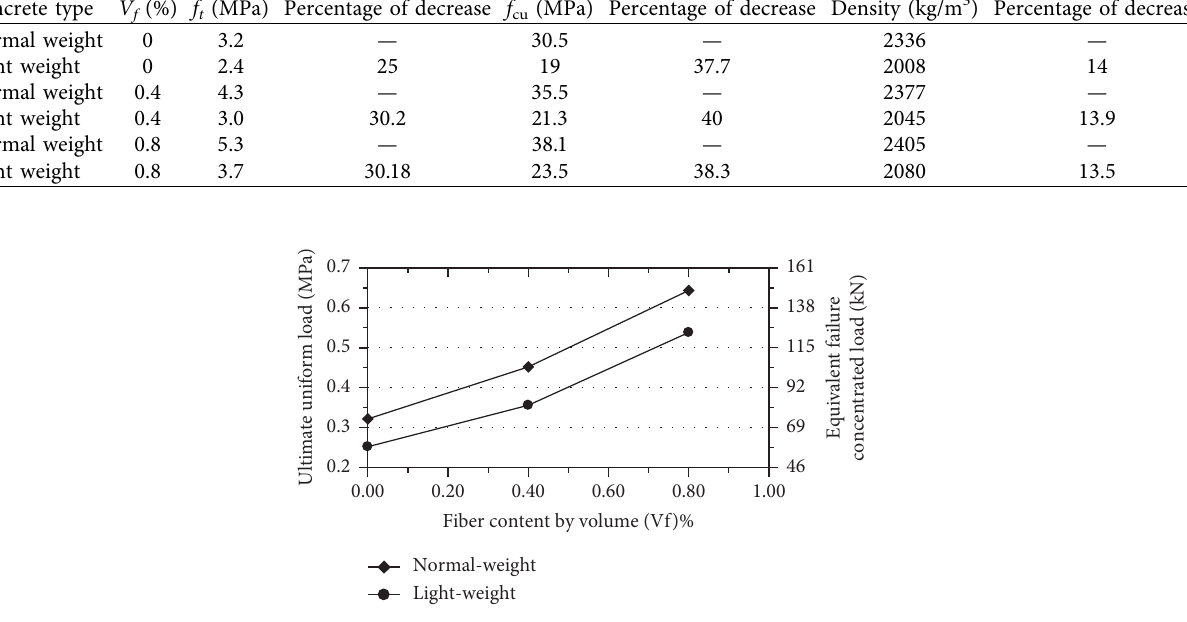
Figure 7: Effect of steel fiber volume fraction ( V f )% on the ultimate uniform load of (normal-weight and lightweight) concrete